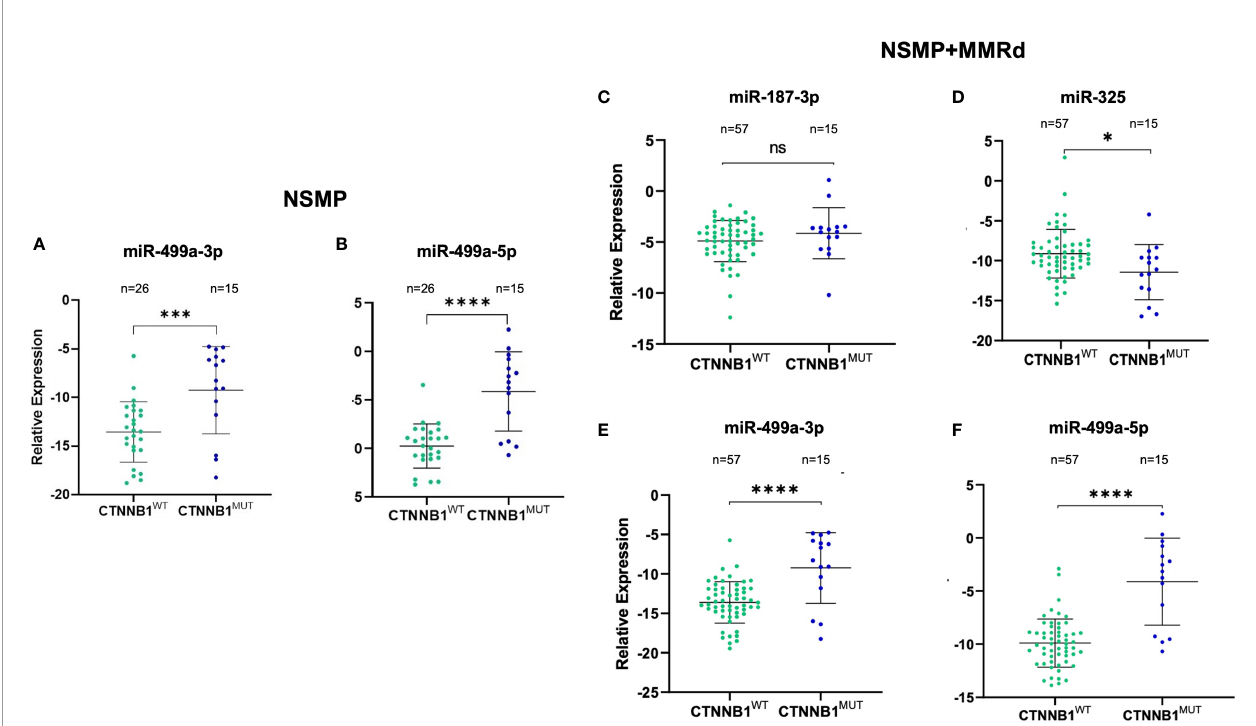
FIGURE 1 | Validation of miR-499a-3p and 499a-5p in the NSMP ECs (n = 41) (A, B) , validation of miR-187-3p (C) , miR-325 (D) , miR-499a-3p (E) , and 499a-5p (F) in the 72 EC samples (NSMP + MMRd). ns, not signi fi cant (p > 0.05); *p < 0.05; ***p < 0.001; ****p <